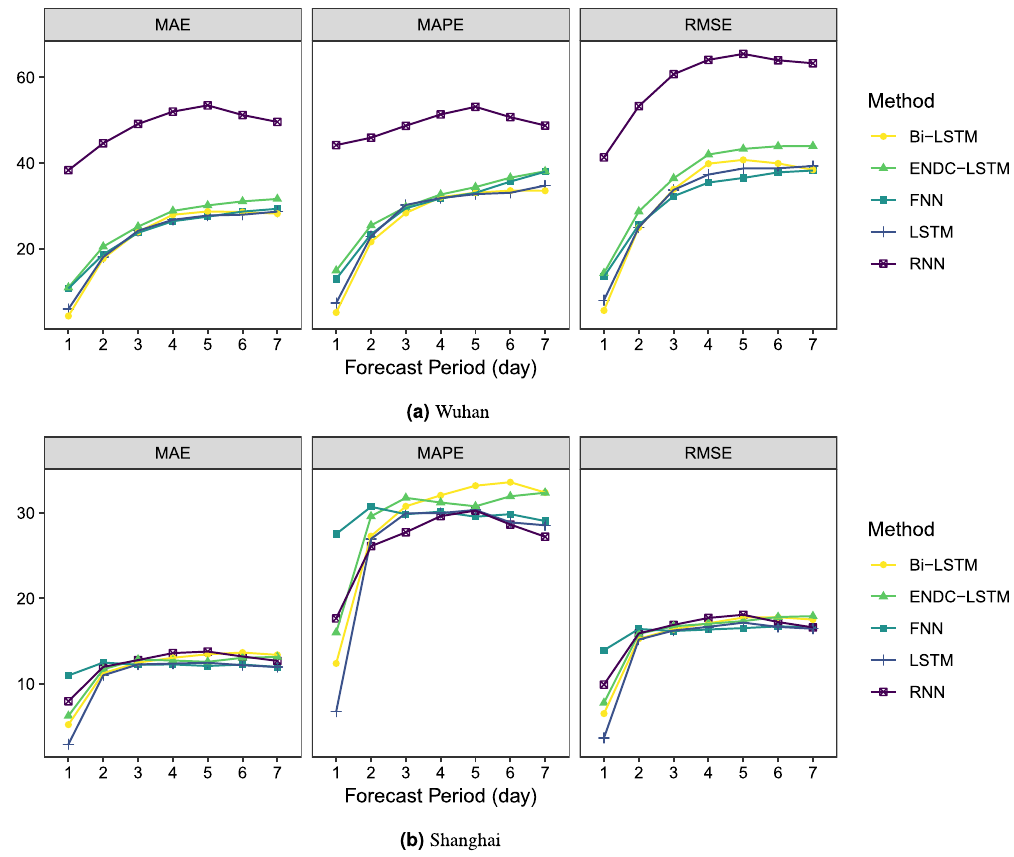
Figure 9. The results of the proposed model and other benchmarks.